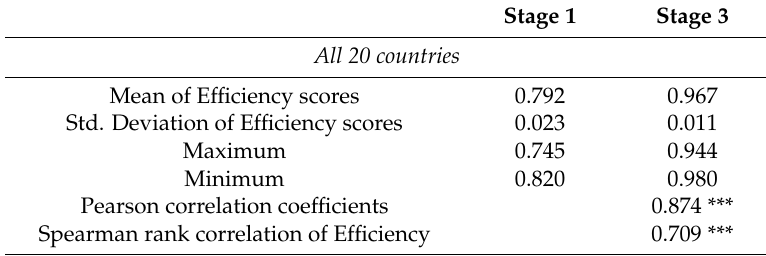
Table 6. The scores of Efficiency of the stage 1 in years